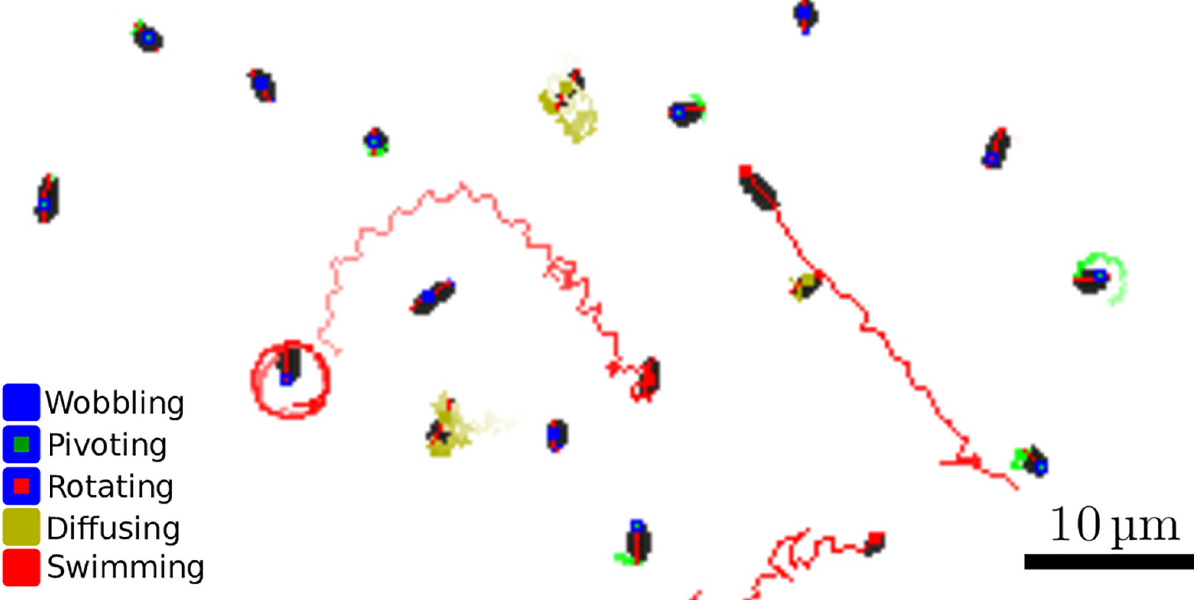
Fig 2. Trajectories of bacteria on the surface. The image is black/white-inverted (w.r.t. the filtered image in Fig 1b) and thresholded to be clear in print. For each cell in the image, the point of minimal motion (anchoring point for adherers) is marked with a square. The combination of the inner and outer color of the square denotes the cell type (see legend). For swimmers and diffusers, the traces show the trajectory of the point of minimal motion. For adherers the trace shows the trajectory at the cell’s point of maximum motion (one of its poles) to visualise pivoting or active rotation